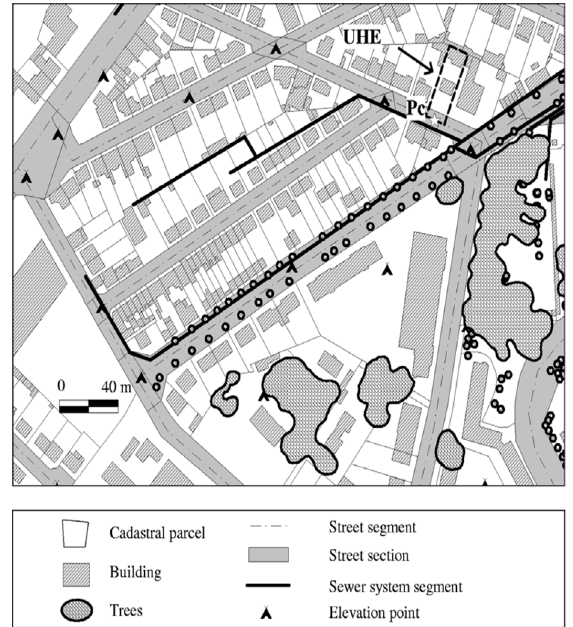
Figure 1. Illustration of detailed spatial representation of an urban catchment in Nantes, France within the Urban Runoff Branching Structure (URBS) model, showing the characteristic cadastral size (adapted from [29]). In the figure, an urban hydrological element (UHE) is delineated by a dashed bold line, which encompasses a cadastral parcel and its adjacent street surface. The connection point to the hydrological network is represented as (Pc).